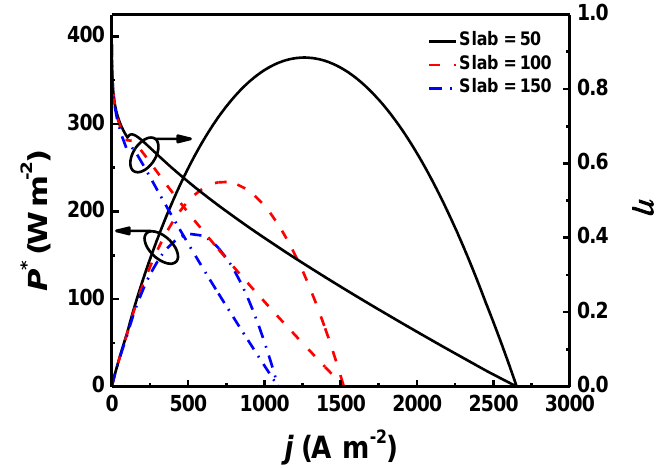
Figure 4. Effects of anode thickness on the hybrid system performance.